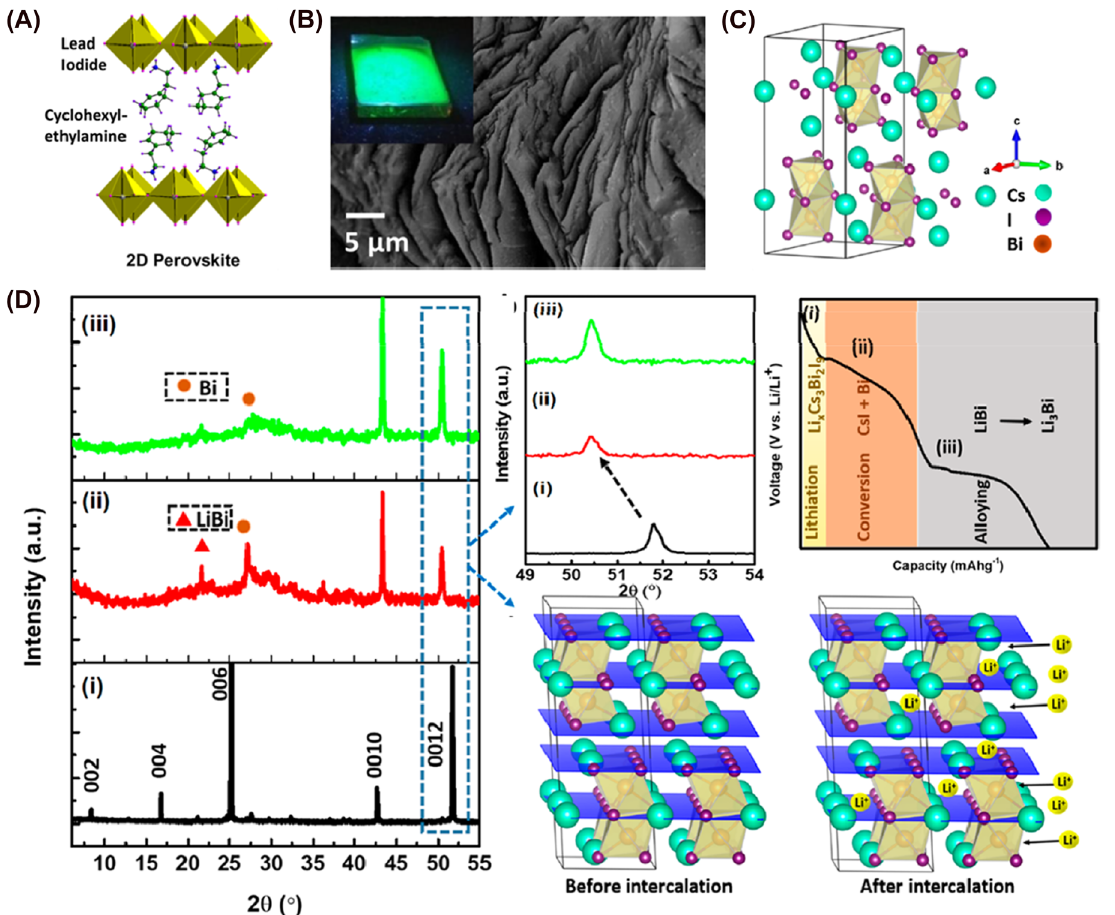
Figure 9: Perovskite-based photoelectrodes. (A) Representation of the crystal structure of 2D CHPI. (B) SEM image of 2D CHPI perovskite PE taken at 45 ° tilt. The inset corresponds to a photoluminescence (PL) image of the perovskite fi lm ( λ ex ∼ 300 nm)[293]. Copyright 2018, American Chemical Society. (C) Crystal structureof Cs 3 Bi 2 I 9 .(D)XRDpatternsofCs 3 Bi 2 I 9 atvariousstagesof adischargecycle(i, ii,iii)with amagni fi edviewofthecharacteristicpeak (0012);the discharge curve showing the three phases of discharge and the crystal structure before and after Li + intercalation [294]. Copyright 2021, American Chemical